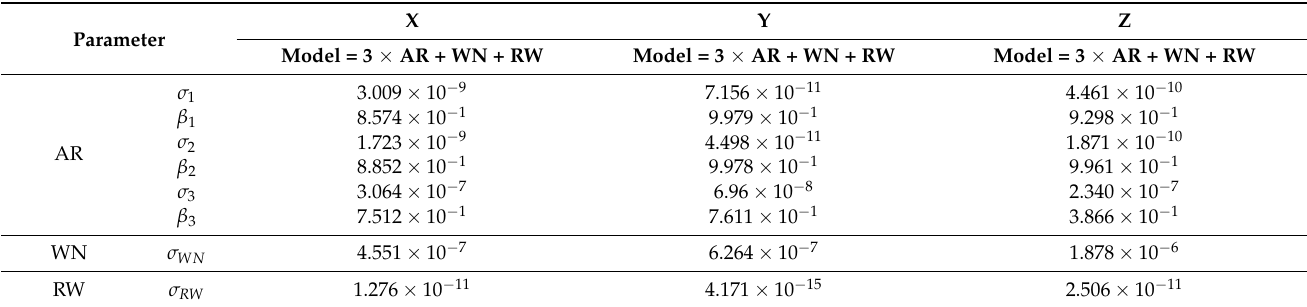
Table 4. The parameter estimation results of GMWM-based method.